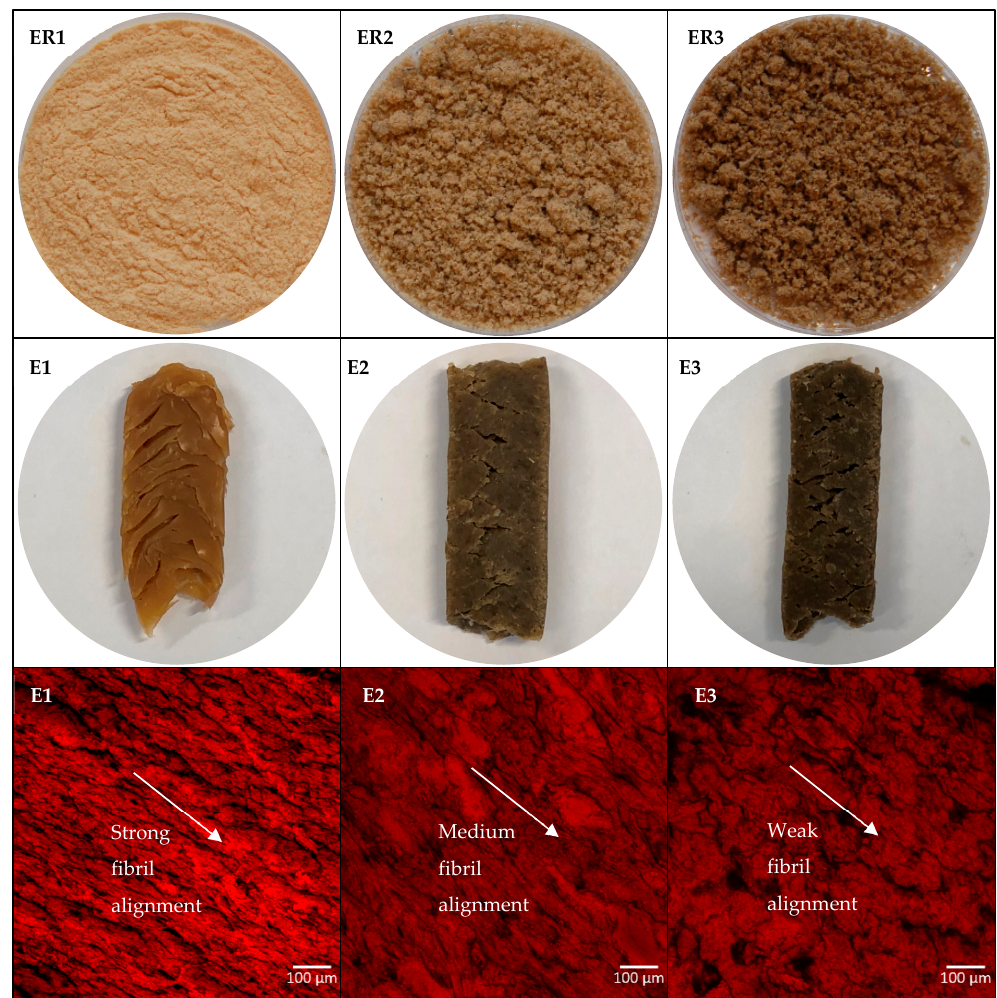
Figure 1. The appearance and the colour of the extrusion raw materials (ER1–ER3) and extrudates (E1–E3), and microstructure of the extrudates (E1–E3). The extrudates were stained with Acid Fuchsin to visualise proteins in red. Fibril alignment direction (strong, medium, weak) is indicated by the arrow.